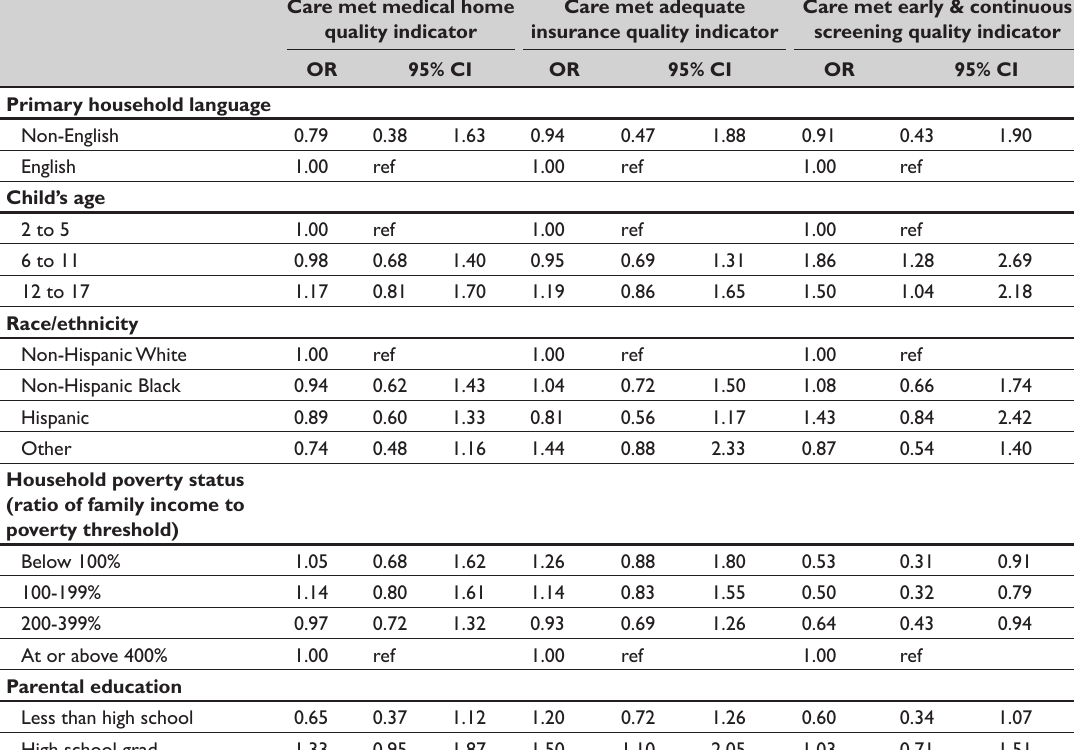
Table 3. Adjusted Odds Ratios for Care Meeting Quality Indicators among Children with Autism Spectrum Disorders